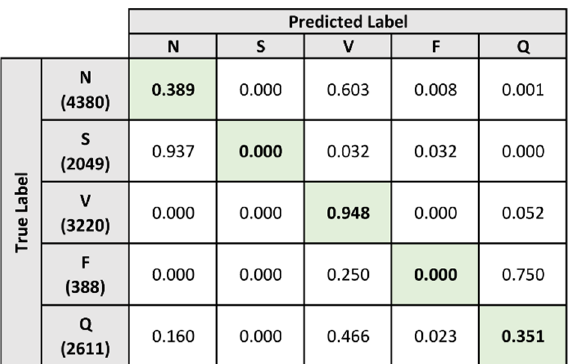
Figure 16. Normalized confusion matrix for baseline model on single-lead dataset.